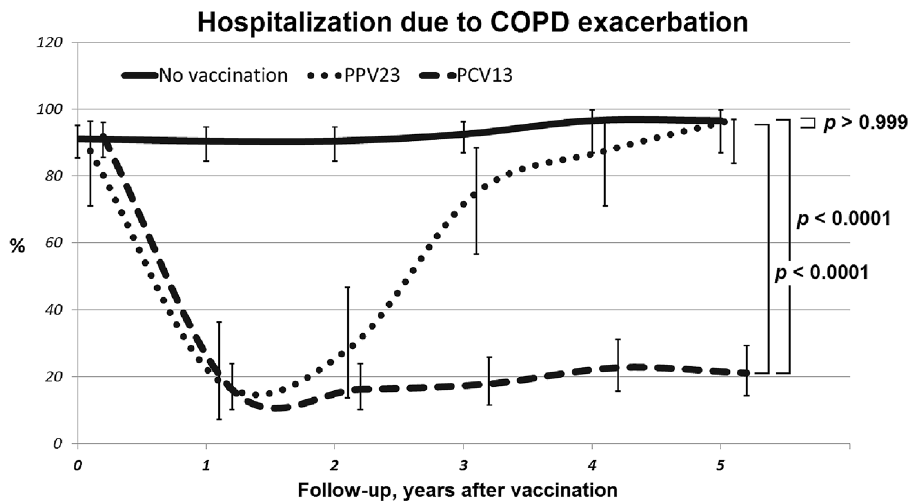
Figure 3. Dynamics of hospitalizations due to COPD exacerbation in the study groups. The P value shows ANOVA statistics between